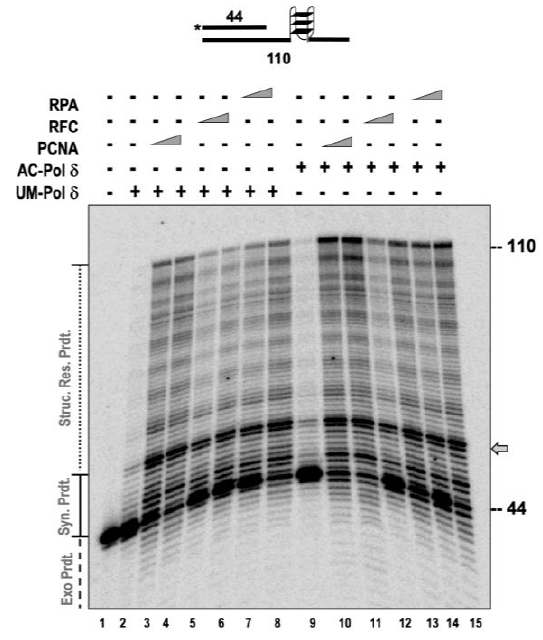
Figure 5. Accessory proteins stimulate the structure resolution activity of UM and AC-pol δ . The structure resolution activity of pol δ was assayed on 5 nM substrate (U 1 :T 6 ) containing a G-quadraplex in the template in the presence of 10 nM of UM or AC-pol δ . Increasing the concentrations of PCNA (200 and 400 nM), RFC (100 and 300 nM), or RPA (100 and 200 nM) were incubated along with the substrate and both forms of the polymerase. The substrate is depicted above the gel image and the asterisk denotes the location of the radiolabel. Exonuclease products (Exo. Prdts.) and structure resolution product (Strd. Res. Prdts.) are indicated adjacent to the gel image. Nucleotide sizes are also indicated. Gray arrows denotes position of stalling.